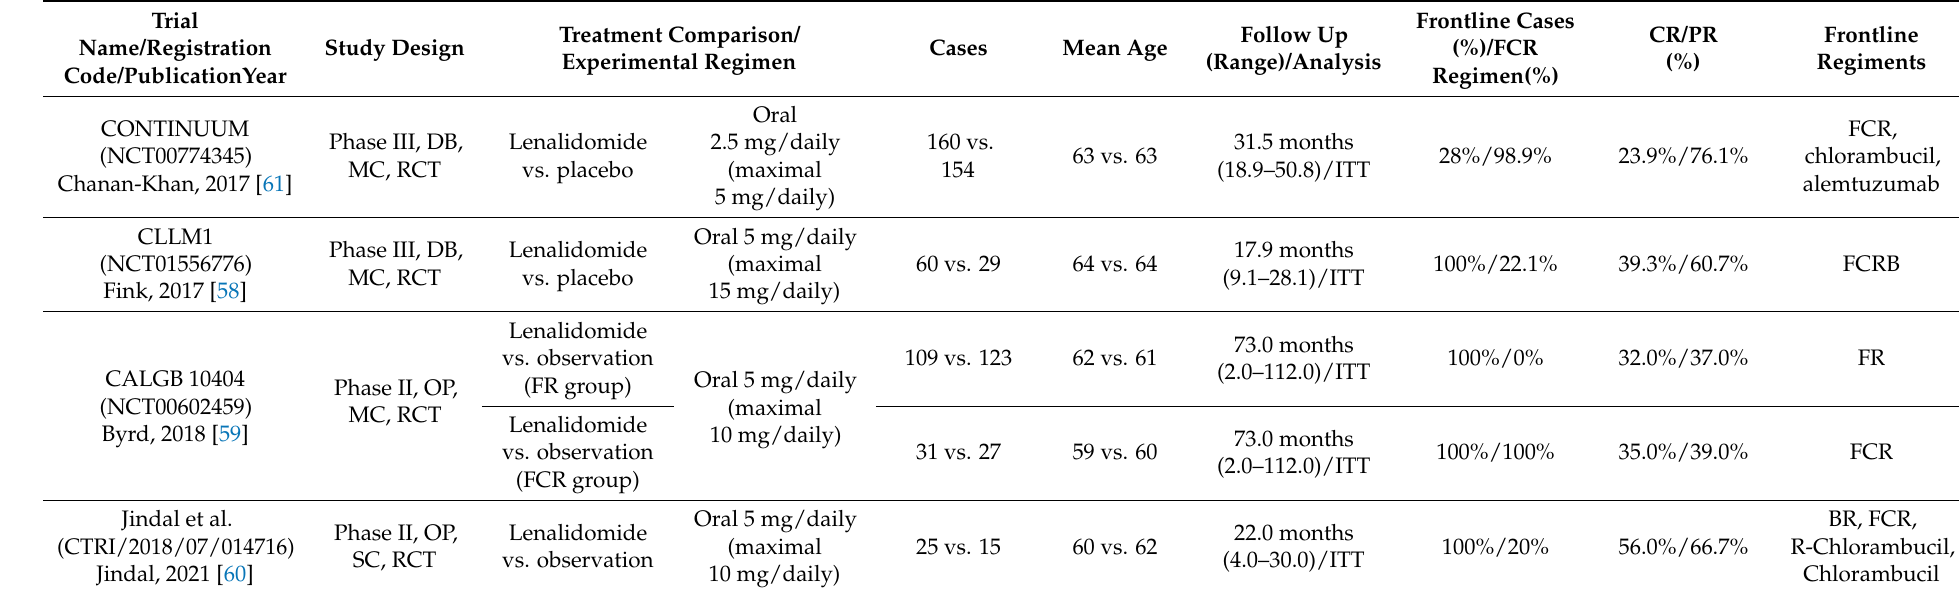
Table 1. Basic characteristics of included randomized